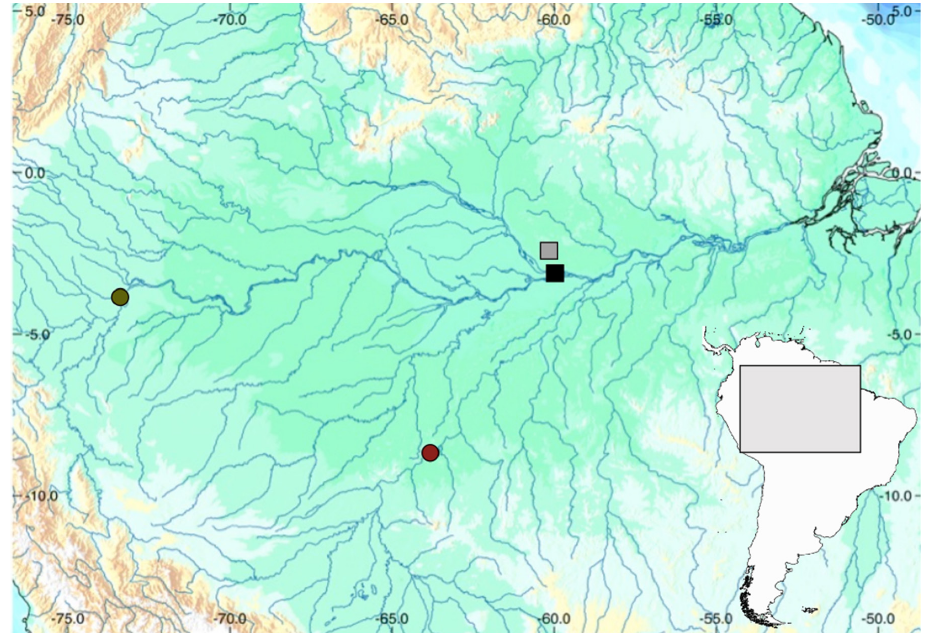
FIGURE 2 | Map showing the geographical position of the four populations of Crenuchus spilurus used in this study. Shapes represent the two main lineages that each population represents; squares for the Negro lineage and circles for the Amazonas lineage. Classification of lineages follows Pires et al.